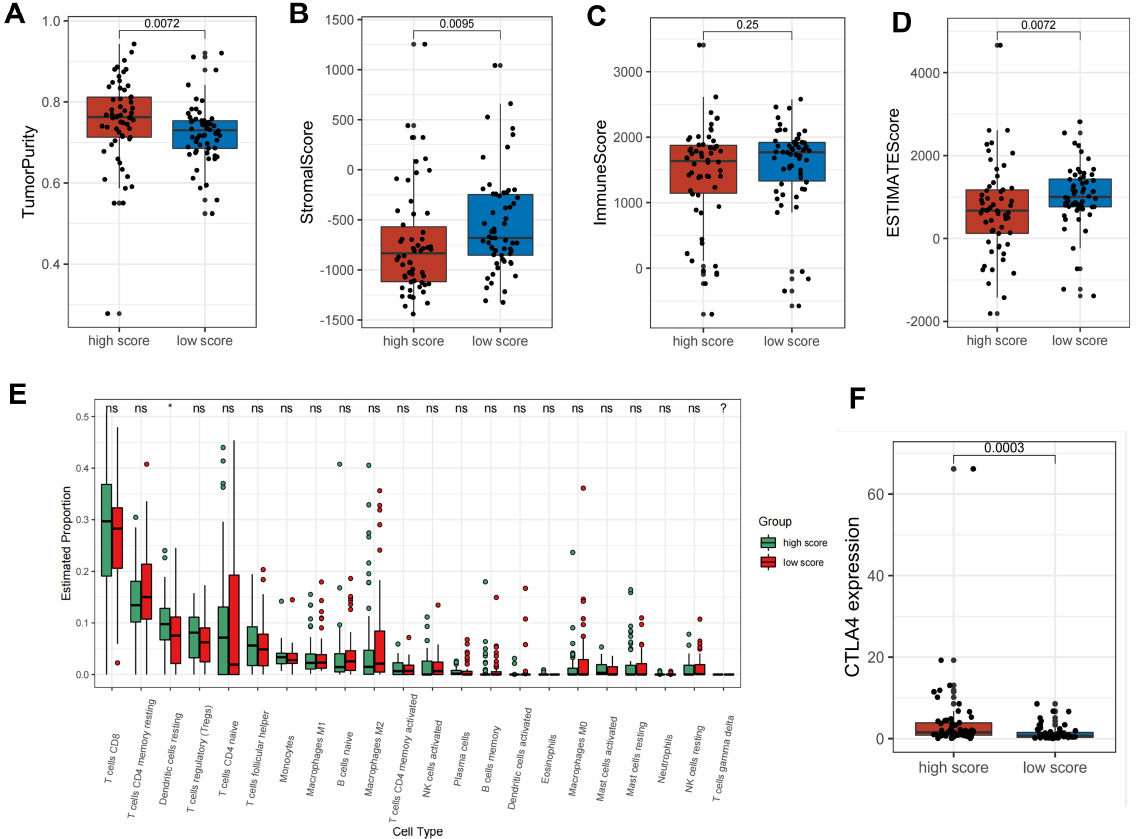
Figure 5. Distinct immune landscapes of metabolic patterns. ( A – D ) Box plots of tumor purity scores, stromal scores, immune scores and estimate scores in high- vs. low-metabolic-score groups. ( E ) The infiltrating levels of 22 immune cell types in high- vs. low-metabolic-score groups. ( F ) Comparison of the CTLA4 expression levels between the two metabolic score groups. ns: non-significant; * p < 0.05.